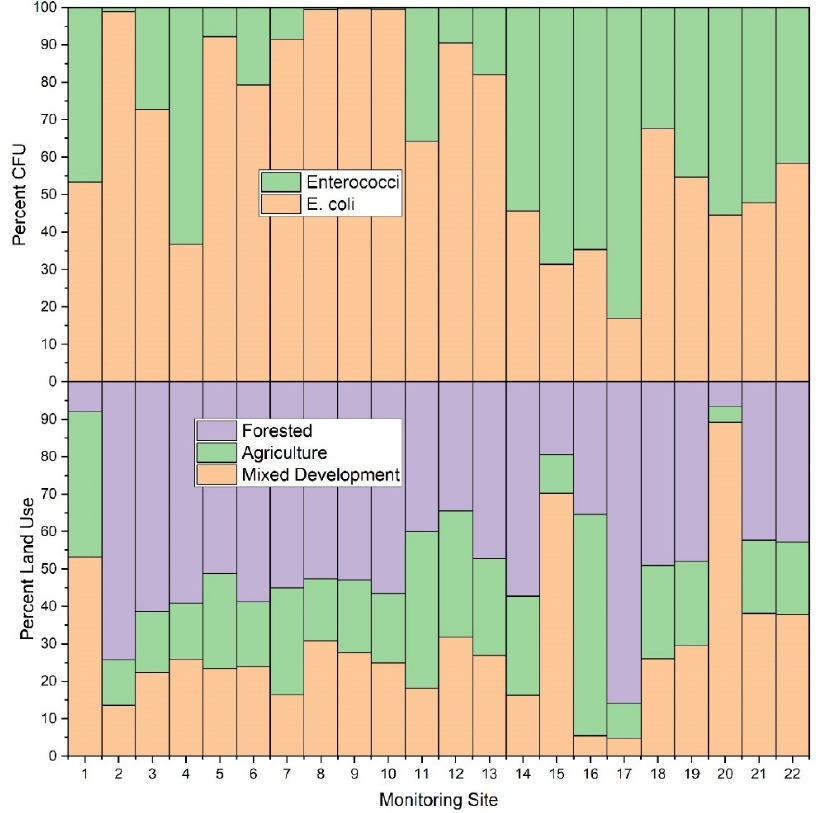
Figure 7. Average E. coli and enterococci concentration (CFU per 100 mL) and relative land use (%) for each sampling location (n = 22) during the study period (3 March–3 November 2020) in West Run Watershed, Morgantown, WV, USA.